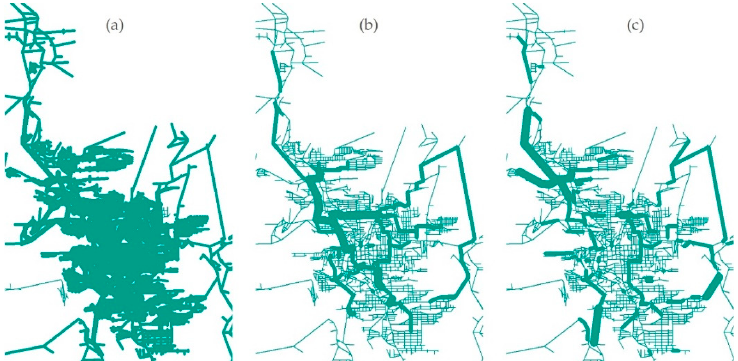
Figure 4. Spatial distribution of centralities for street segments (dual representation): ( a ) Closeness Centrality; ( b ) Betweenness Centrality; ( c ) Information Centrality. Source: Authors, July 2018.